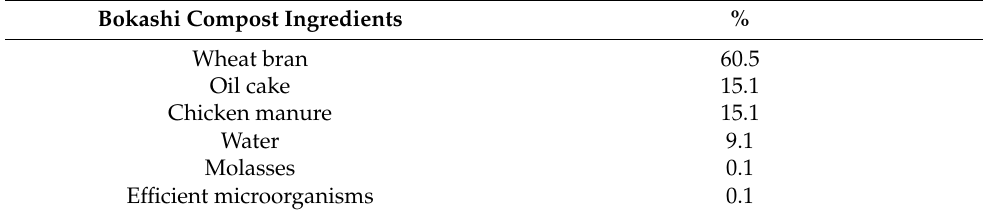
Table 7. Percentage composition of bokashi compost. Bokashi Compost